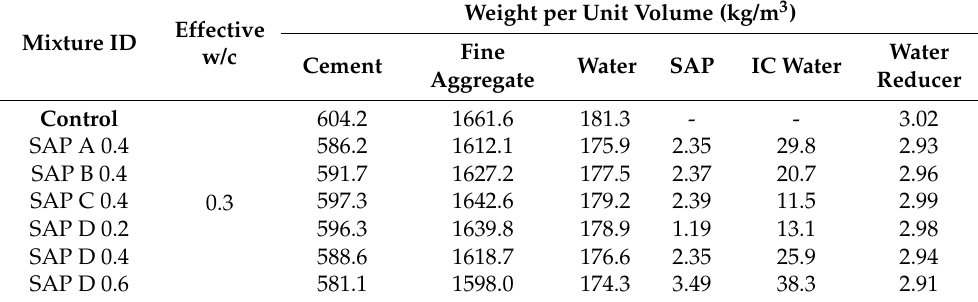
Table 4. Mixture proportions of